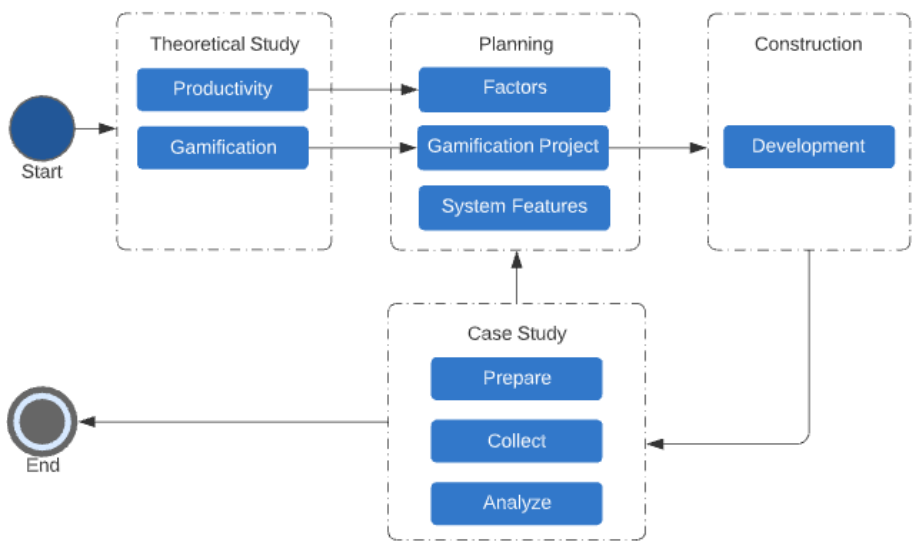
Figure 1. Steps and procedures adopted in the